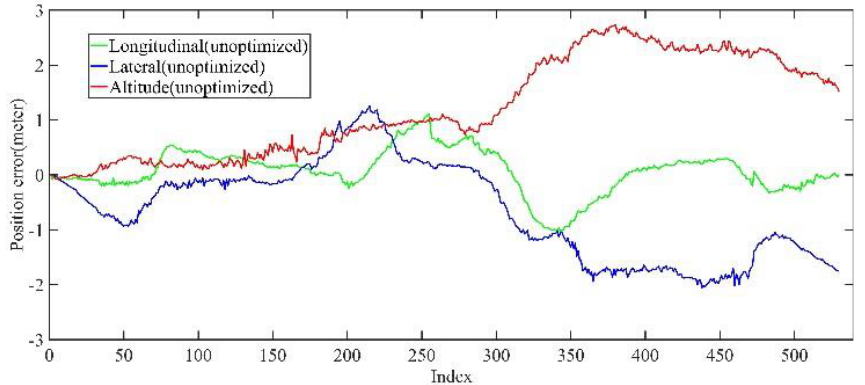
Figure 16. Small scale scenario unoptimized mapping trajectory position error in longitudinal, lateral, and altitude directions. Before optimization, the error is at the meter level.